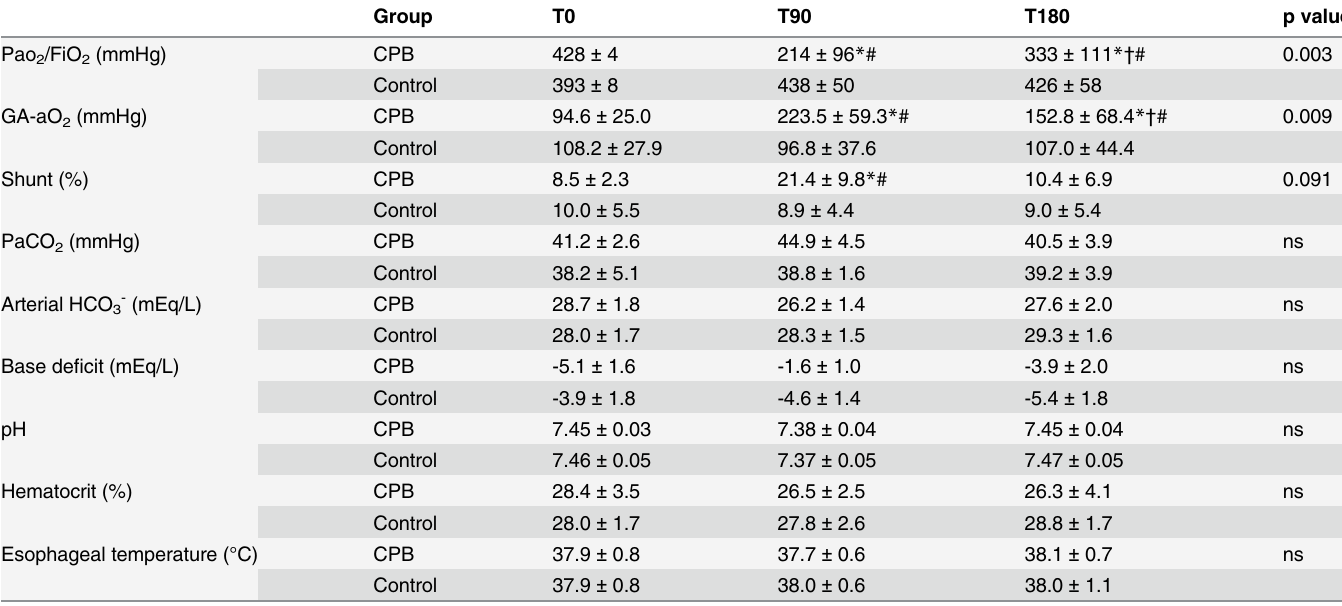
Table 3. Oxygenation and metabolic variable behavior throughout the